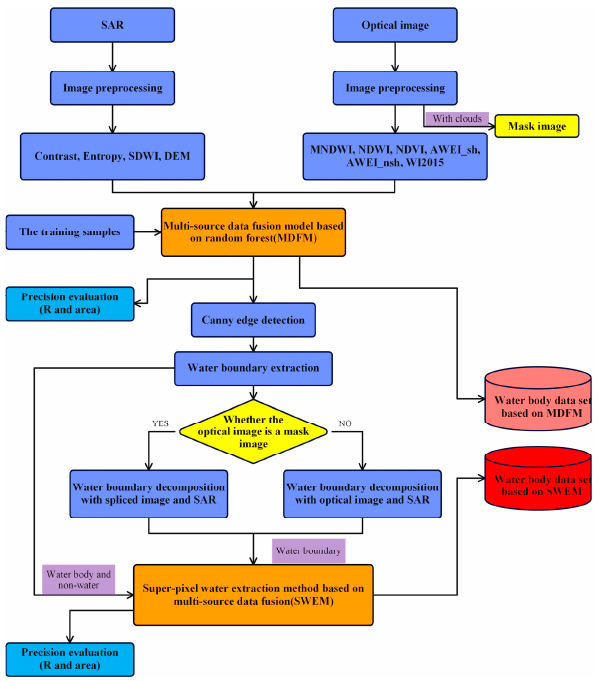
Figure 3. Flow chart of MDFM and SWEM.